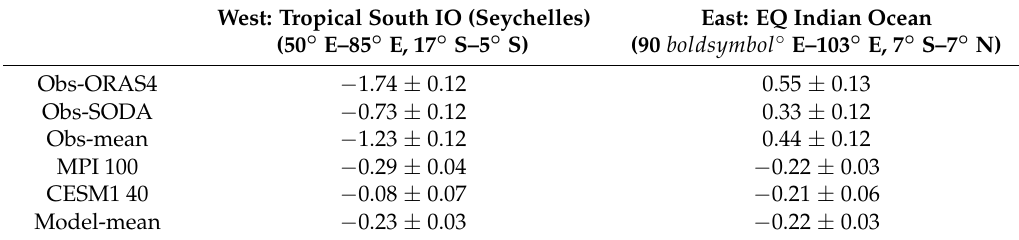
total of 140-member ensemble; their trend values are obtained from the 100-member ensemble averages of external forcing effect, with each of the 100 members being an ensemble mean of randomly chosen N members using the Monte Carlo method; uncertainties indicate 1.65 standard deviations of the external forcing spread, as discussed in detail in the